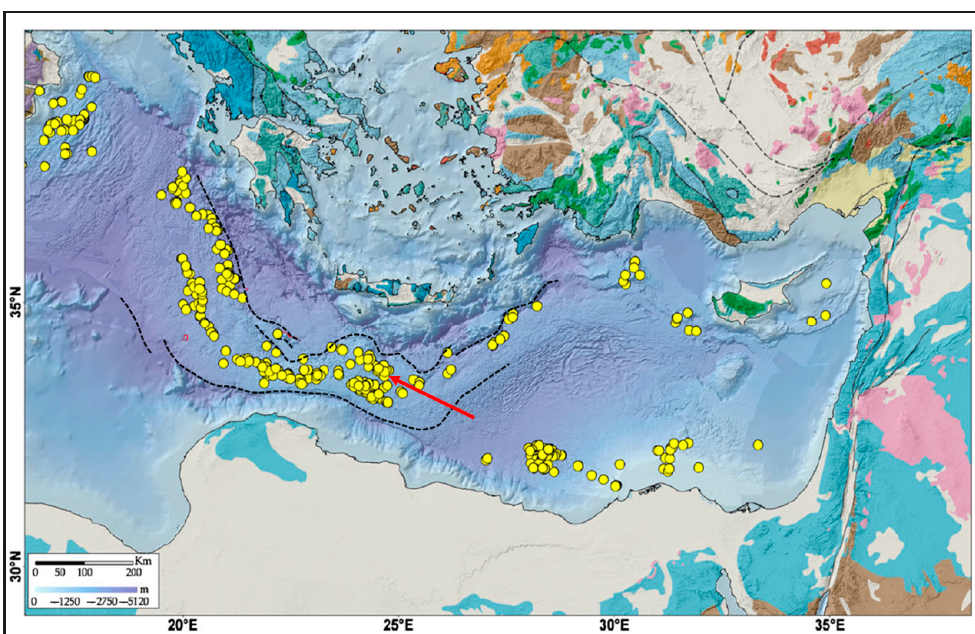
Figure 1. Spatial distribution of the mud volcanoes (see the yellow bullets) in the eastern Mediterranean basin. The thick dashed lines indicate the northern and southern boundaries of the central Mediterranean Ridge, while the red arrow indicates the approximate location of the Olimpi mud volcano field. Modified from Mascle et al. [5]; see [16] for the explanation of the additional information shown on the map.